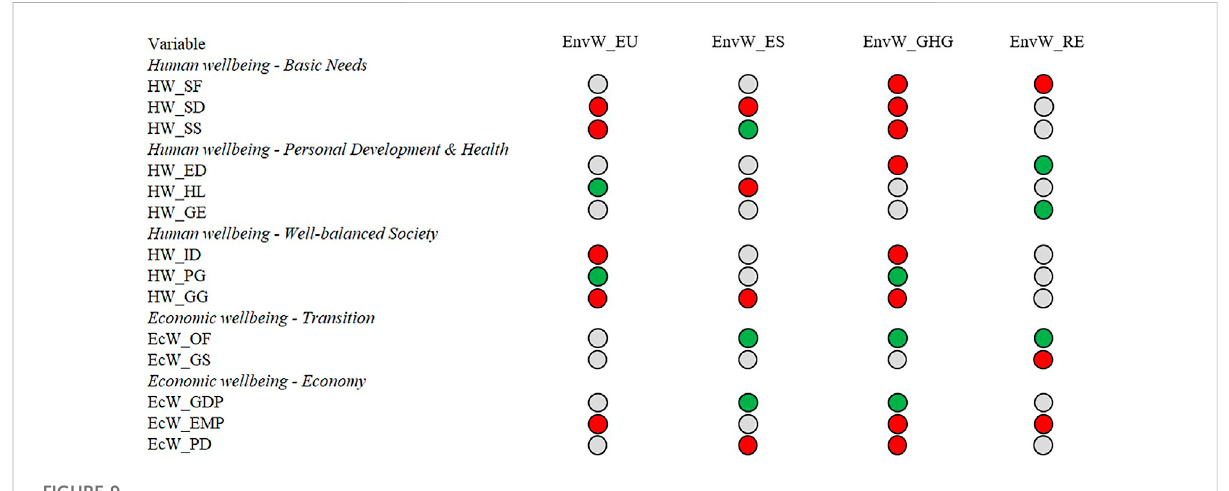
FIGURE 9 Snapshot of panel analysis